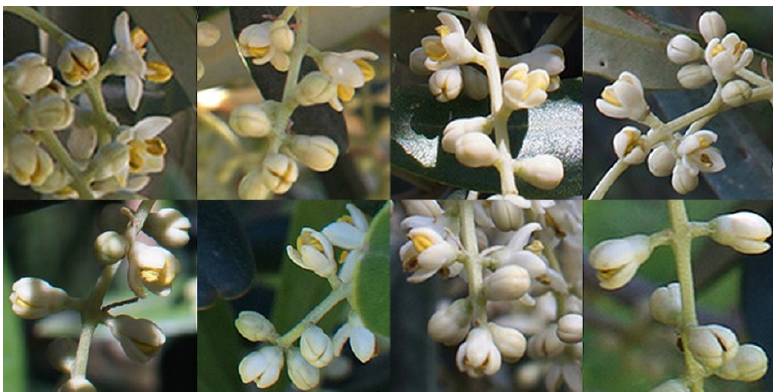
Figure 9. Samples of transitions from buds to open flowers.